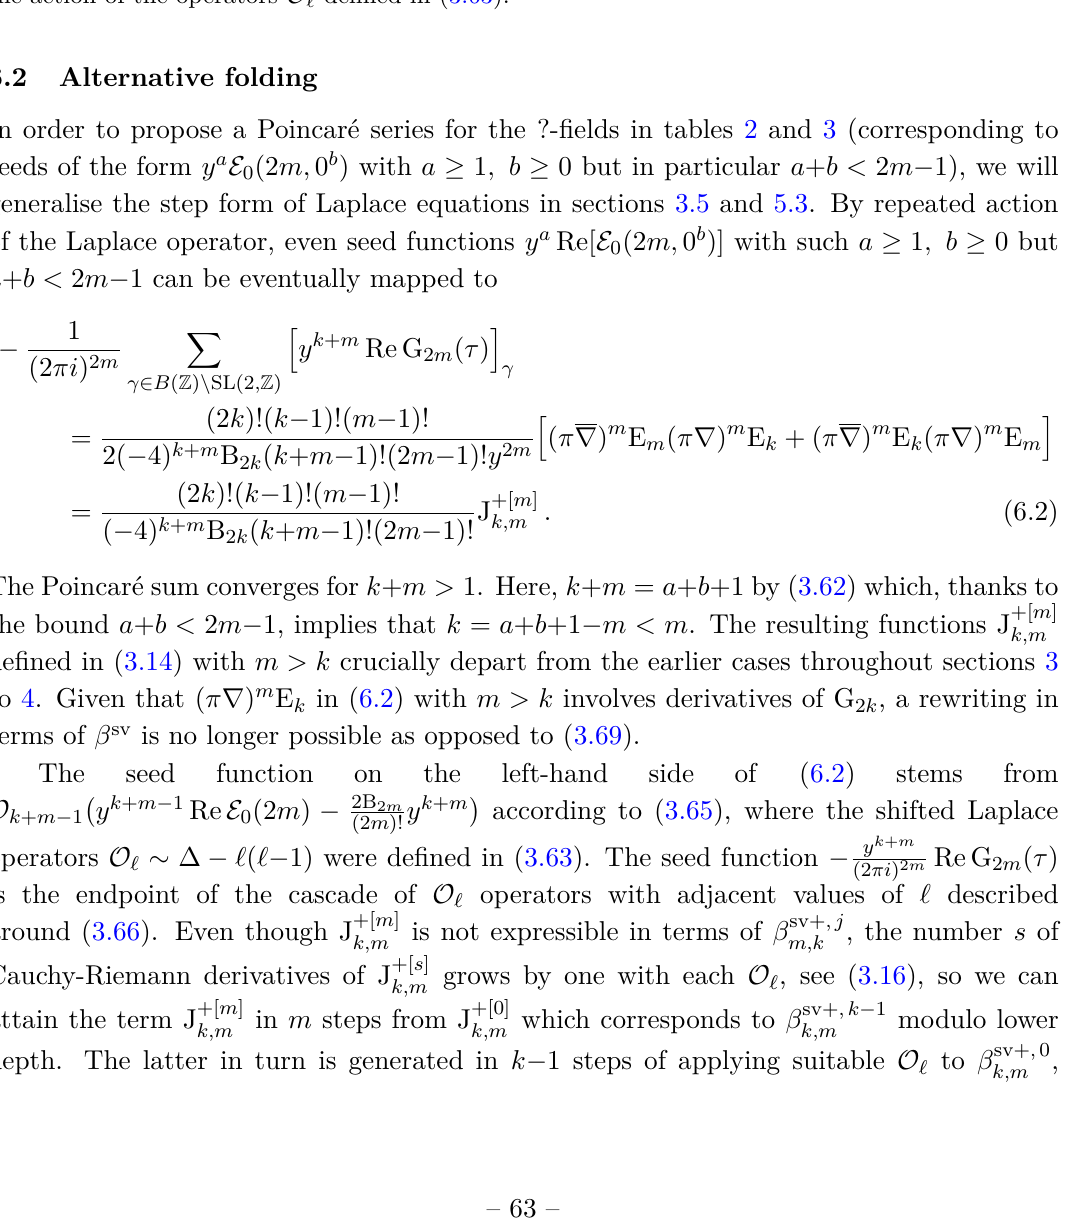
Table 3 . Leading-depth terms β sv ,j the action of the operators O